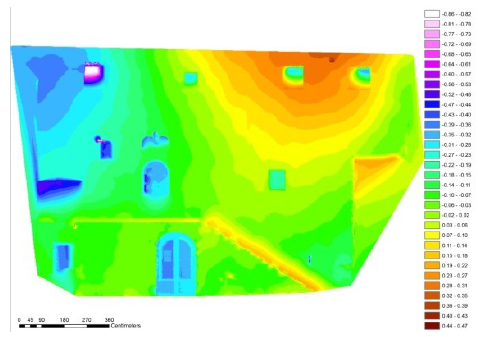
Figure 5: Contour line (North-West)